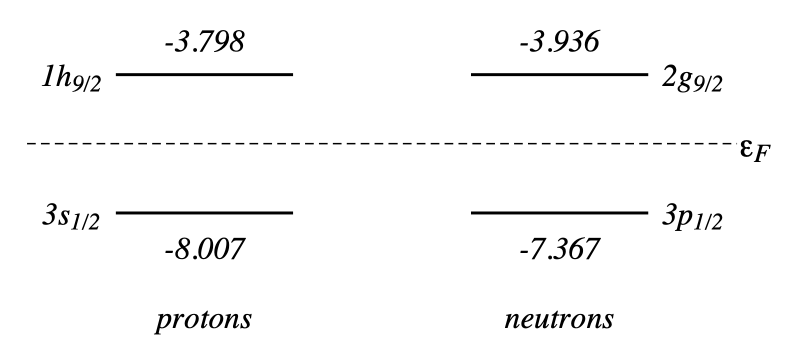
Figure 1. Sketch of the s.p. levels around the Fermi surface in 208 Pb. The numbers indicate, in MeV units, the s.p. energies obtained as differences between the experimental binding energies of the nuclei with one nucleon more or less than 208